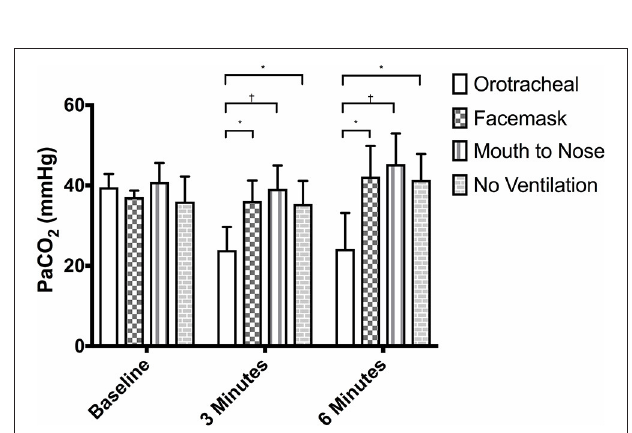
FIGURE 3 | Mean PaCO 2 of dogs at baseline and at 3 and 6min of cardiopulmonary resuscitation when ventilated via one of four techniques without supplemental oxygen. Bars represent standard deviation. * P ≤ 0.01, † P < 0.001. Orotracheal, ventilation with bag resuscitator and cuffed orotracheal tube; Mouth-to-nose, rescue breaths with mouth over the nose; face mask, ventilation with bag resuscitator and a tight fitting face mask; No ventilation, compression only